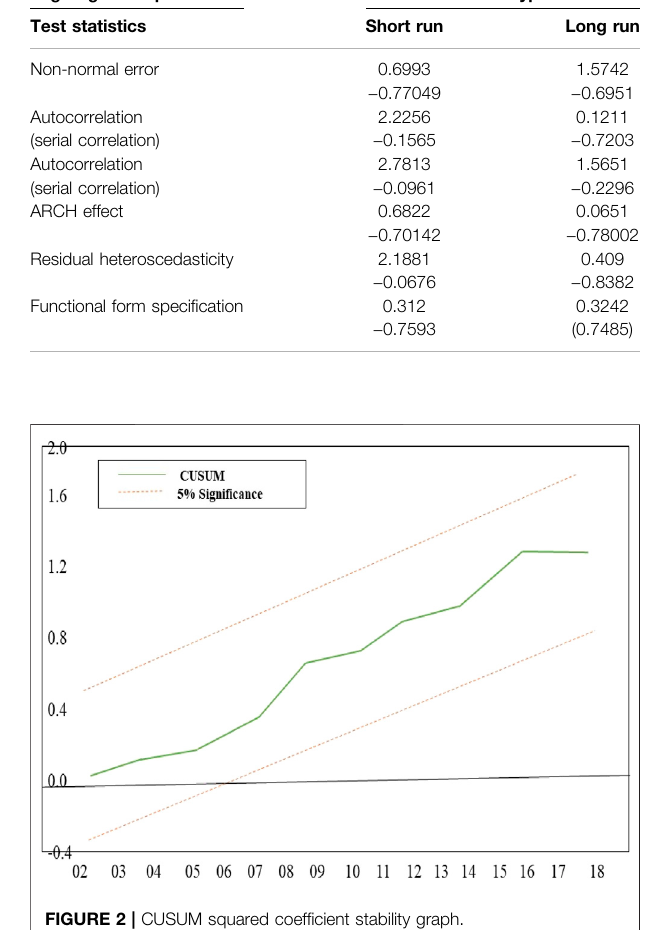
FIGURE 2 | CUSUM squared coef fi cient stability